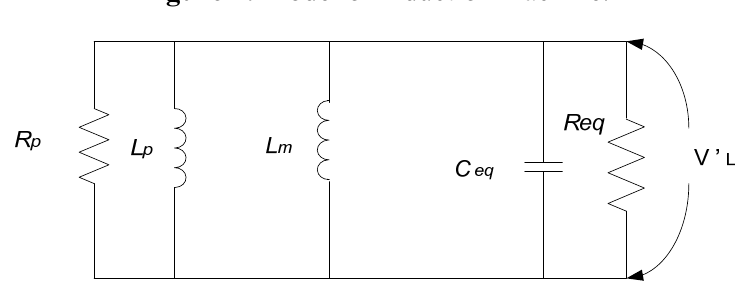
Figure 4. Model of induction